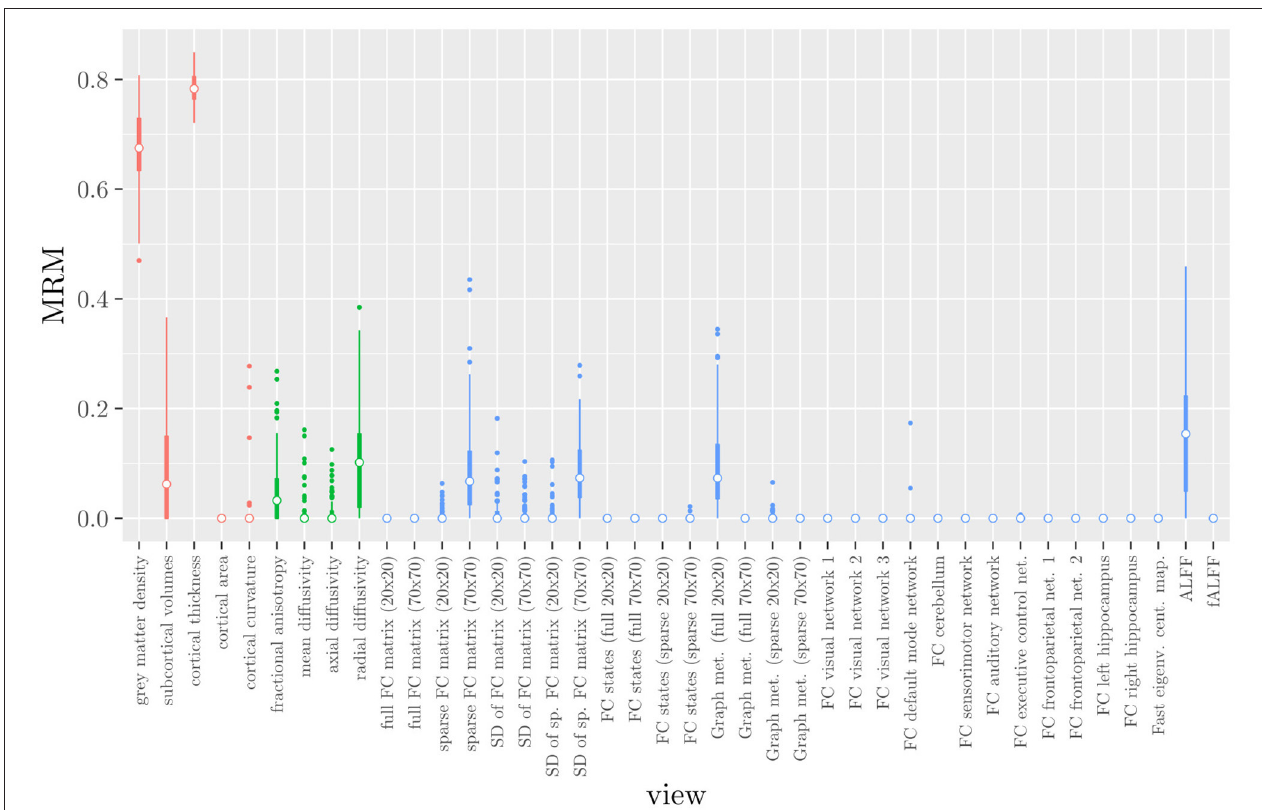
FIGURE 9 | Influence of each of the MRI measures on the predictions of the hierarchical stacked classifier, as quantified by the minority report measure. MRM values range from 0 to 1, with 0 indicating no influence and 1 indicating maximum possible influence. The colors of the bars refer to the different scan types (red = structural MRI, green = diffusion MRI, blue = resting state